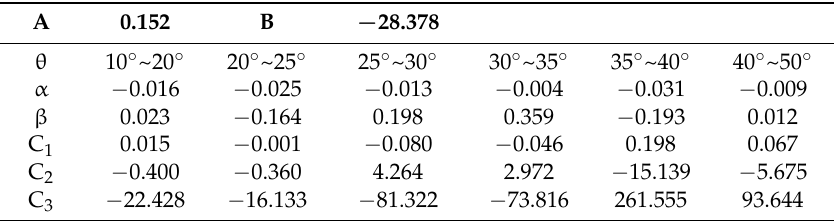
Table 1. Coefficients in Equations (3)–(5), which are determined from the collocated data in our study.